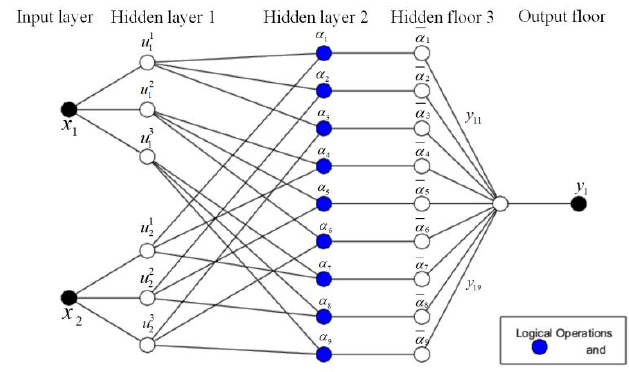
Figure 7. Fuzzy neural network structure diagram.